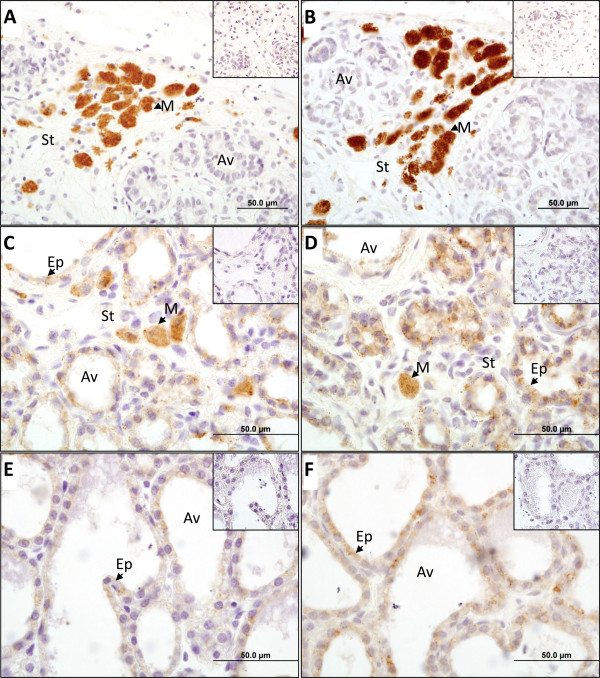
 Immunolocalisation of insulin and IGF2 protein in the tammar mammary gland. Insulin (A), (C) and (E) and insulin-like growth factor 2 (IGF2)(B), (D) and (F) protein (brown staining) localisation in mammary glands at three different stages of lactation. (A), (B) One day before birth (day −1), macrophage cells (M) in the stroma (S) were intensely stained and there was no staining in the alveolar cells (Av). (C), (D) At day 95 of lactation, insulin and IGF2 was detected in the cytoplasm of the alveoli epithelial cells (Ep), with infrequent macrophage cell staining. (E), (F) At day 200 of lactation, staining was concentrated in the epithelial cells of the alveoli. There was no staining in any of the IgG antibody control (top right insert). There was no staining in any of the no-antibody controls (data not shown). Scale bars shown at the bottom right.